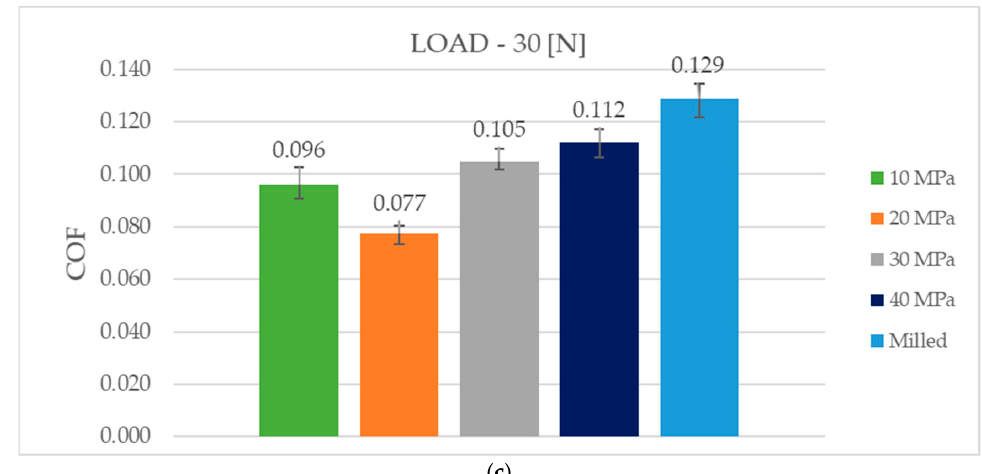
Figure 6. Average values of the friction coefficient for various assemblies under the load of 10 MPa ( a ), 20 MPa ( b ) and 30 MPa ( c ).